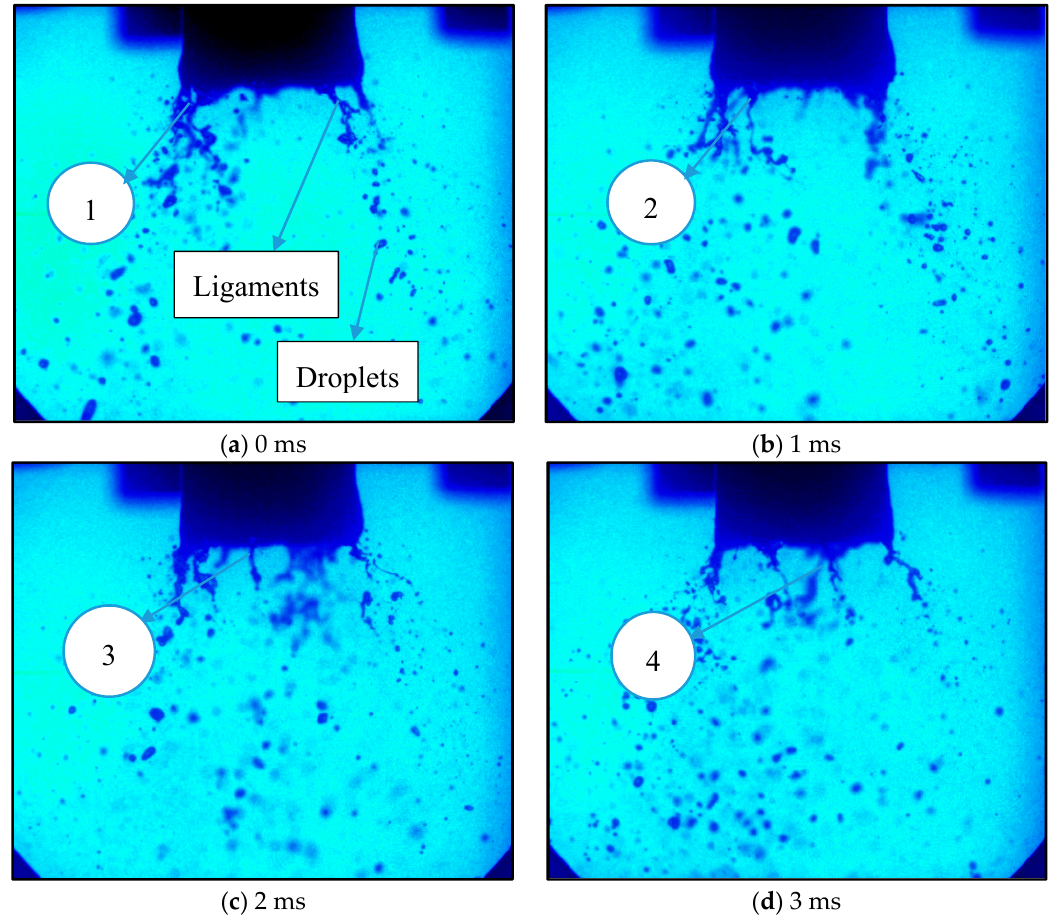
Figure 7. Liquid film breakup process of Case B (Transient results).